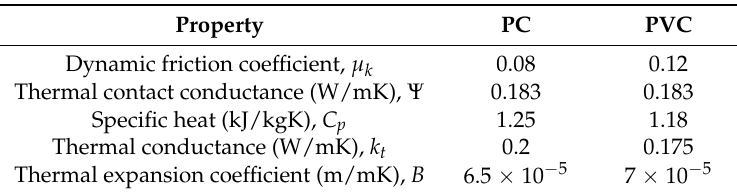
Table 1. Thermal properties for polycarbonate (PC) and polyvinyl chloride (PVC) employed in the numerical model.